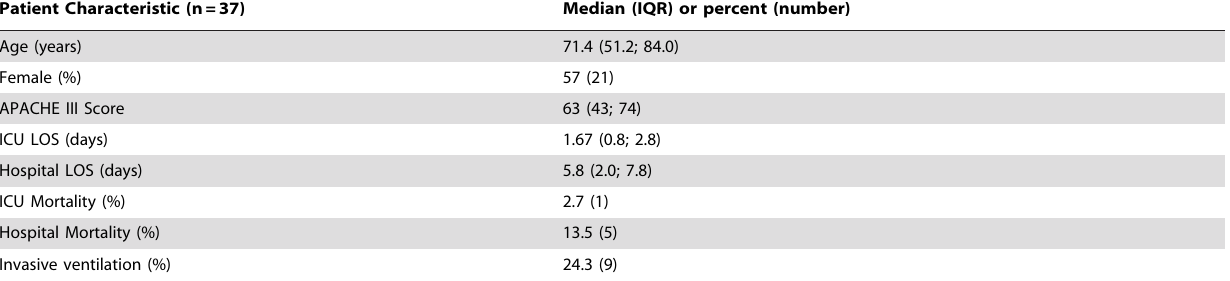
Table 1. Patient